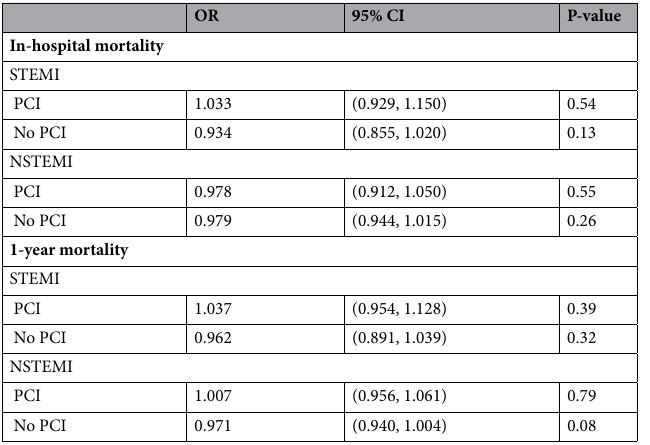
Table 3. Relative risk (odds ratio) of in-hospital mortality and 1-year mortality for patients admitted on weekend in comparison to patients admitted on weekday, stratified by the subtype of myocardial infarction and percutaneous coronary intervention. CI confidence interval, NSTEMI non-ST elevation myocardial infarction, OR odds ratio, PCI percutaneous coronary intervention, STEMI ST elevation myocardial infarction.